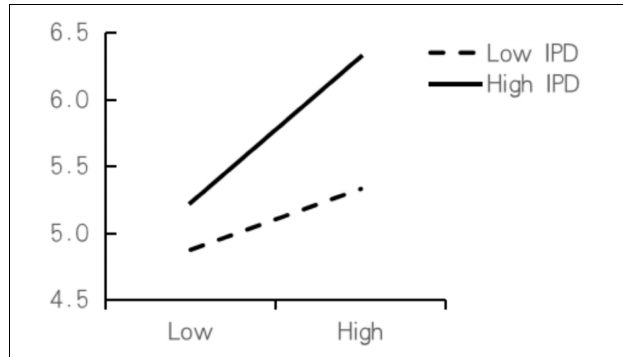
FIGURE 4 | Moderating effect of involvement in purchasing decisions on the relationship between perceived value and satisfaction.